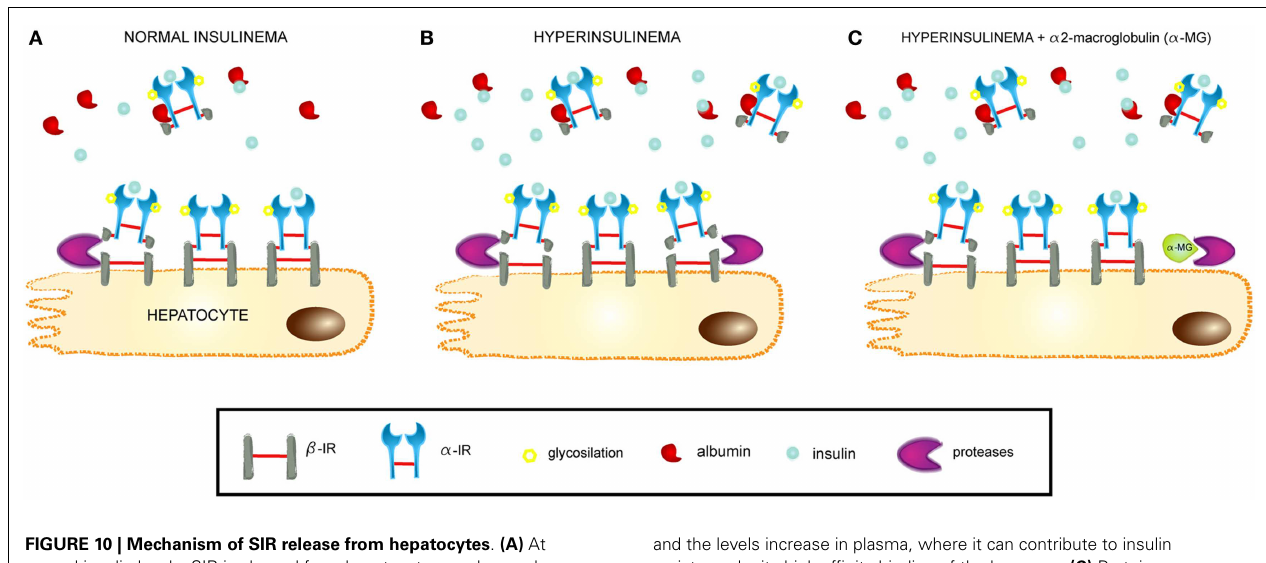
FIGURE 10 | Mechanism of SIR release from hepatocytes . (A) At normal insulin levels, SIR is cleaved from hepatocyte membranes by proteases and passes into the bloodstream, where it retains the ability to bind insulin and also albumin. SIR acts as a physiological carrier for insulin. (B) At hyperinsulinemic conditions, SIR is released